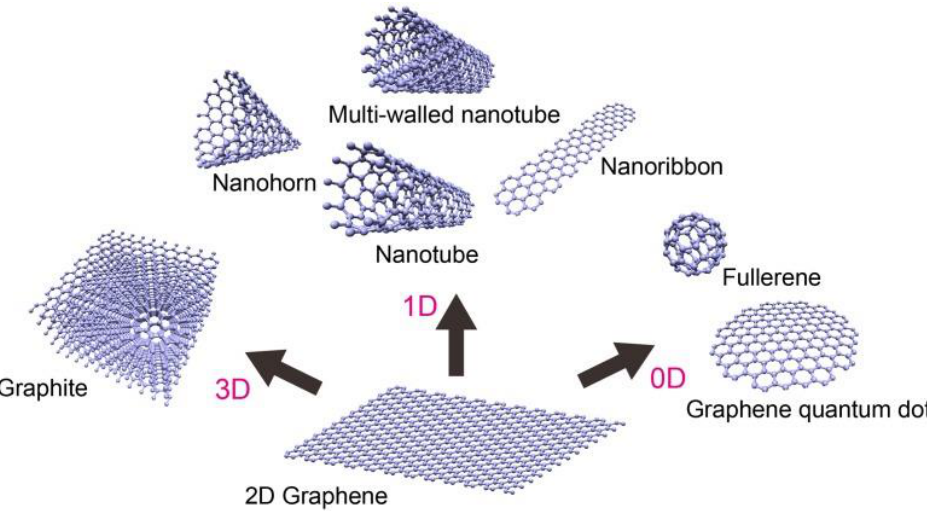
Figure 1. Formation of carbon-based nanomaterials [32].